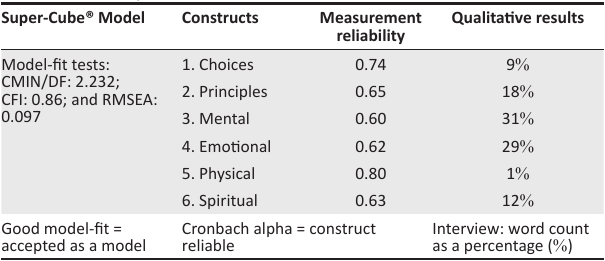
TABLE 8 : Summary of results. Super-Cube® Model Constructs Measurement